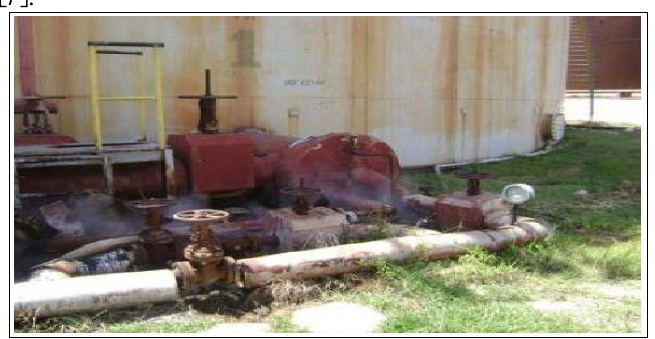
Figura 7: Calentador de Boca de uno de los tanques de almacenamiento de combustible.